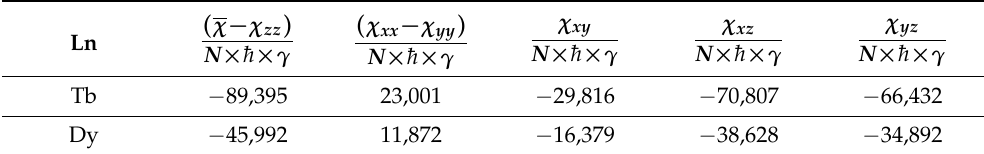
Table 2. Calculated values of the components of the magnetic susceptibility tensor of the Ln cation ( χ − χ zz